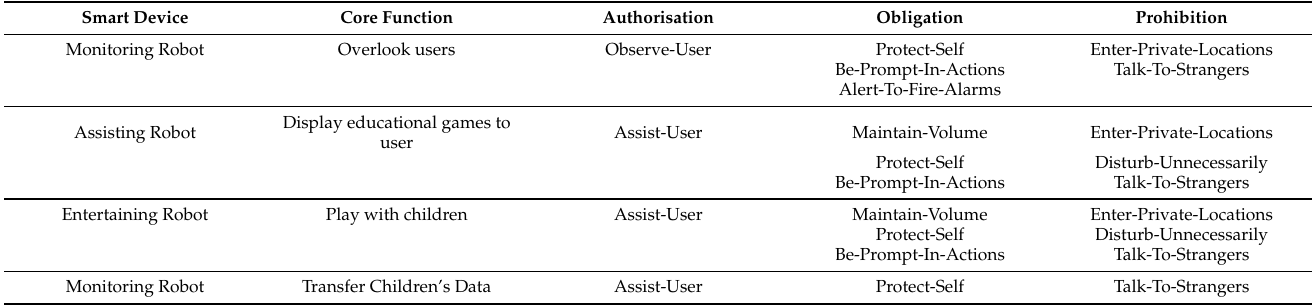
Table 9. Administrative policy rules and core functions mapping—early learning